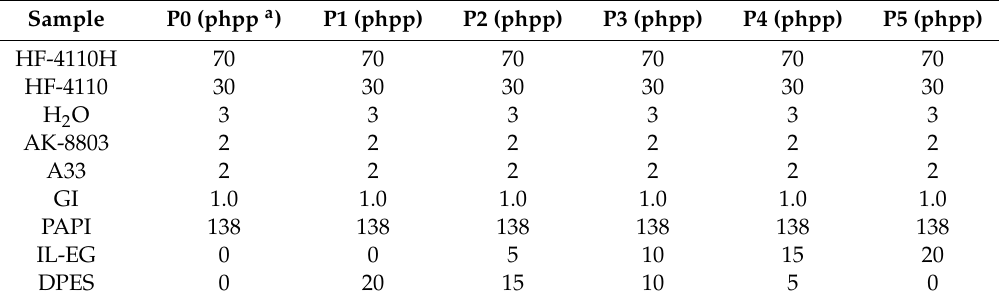
Table 1. Formulations of RPUF / IL-EG